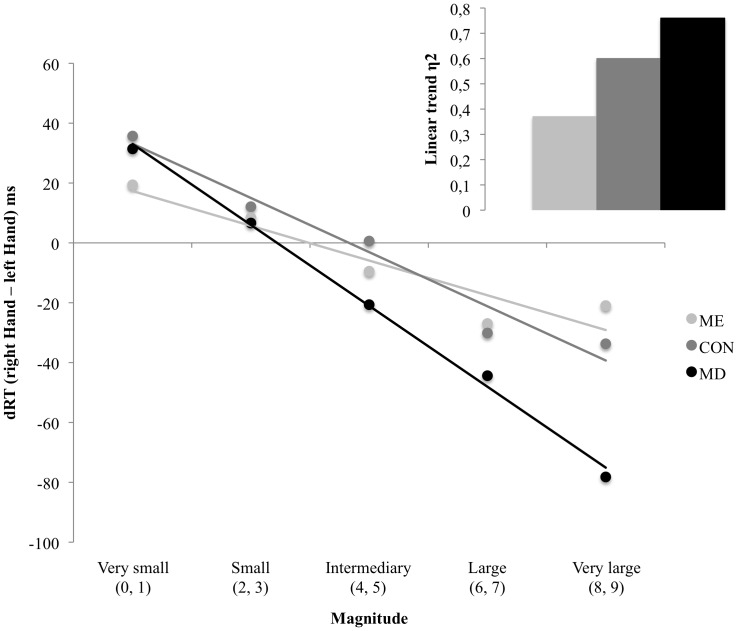
dRT (in ms) as a function of Magnitude category by group.Lines represent the linear fits on group data. A negative relation indicates the presence of a SNARC effect. The inset depicts linear trend effect sizes per group.